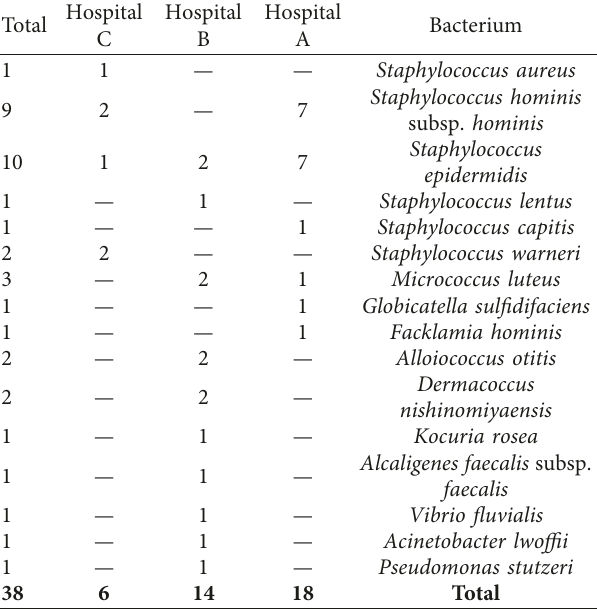
Table 1: Types of bacteria isolated from cell phones of healthcare workers in selected hospitals.